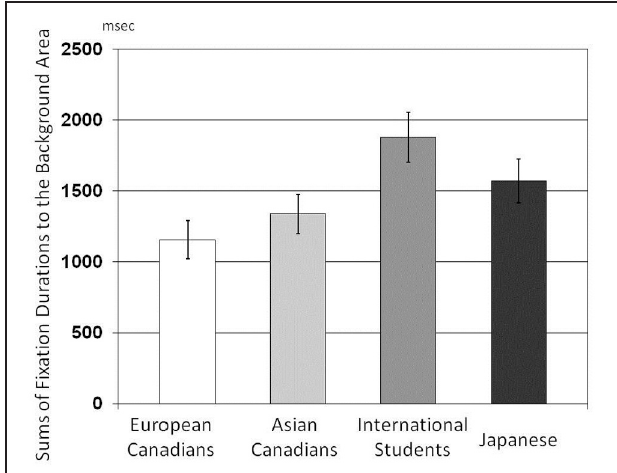
FIGURE 8 | Comparison of sums of fixation durations to the Background Area for the four cultural